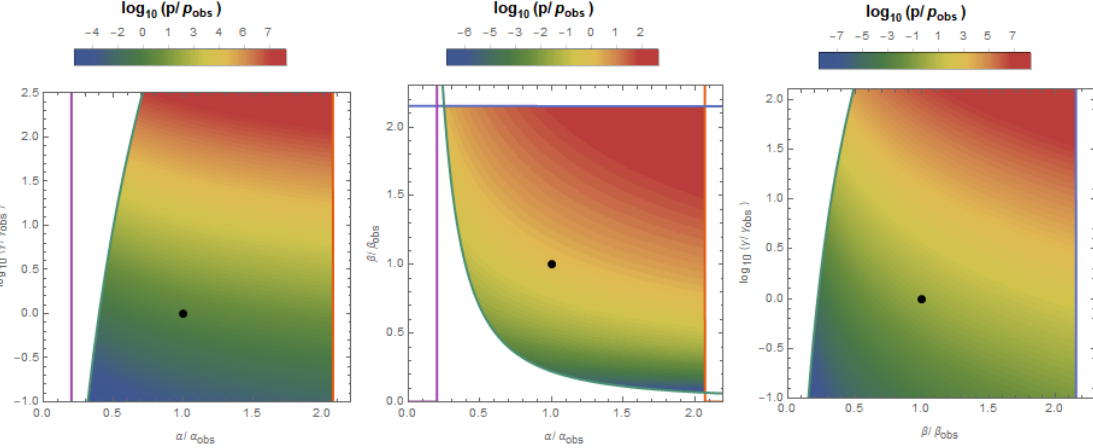
Figure 4. Distribution of observers if life may only exist within the temperate zone, in the α – γ , α – β , and β – γ subplanes. The teal line is the boundary for which planetary disks are smaller than the temperate